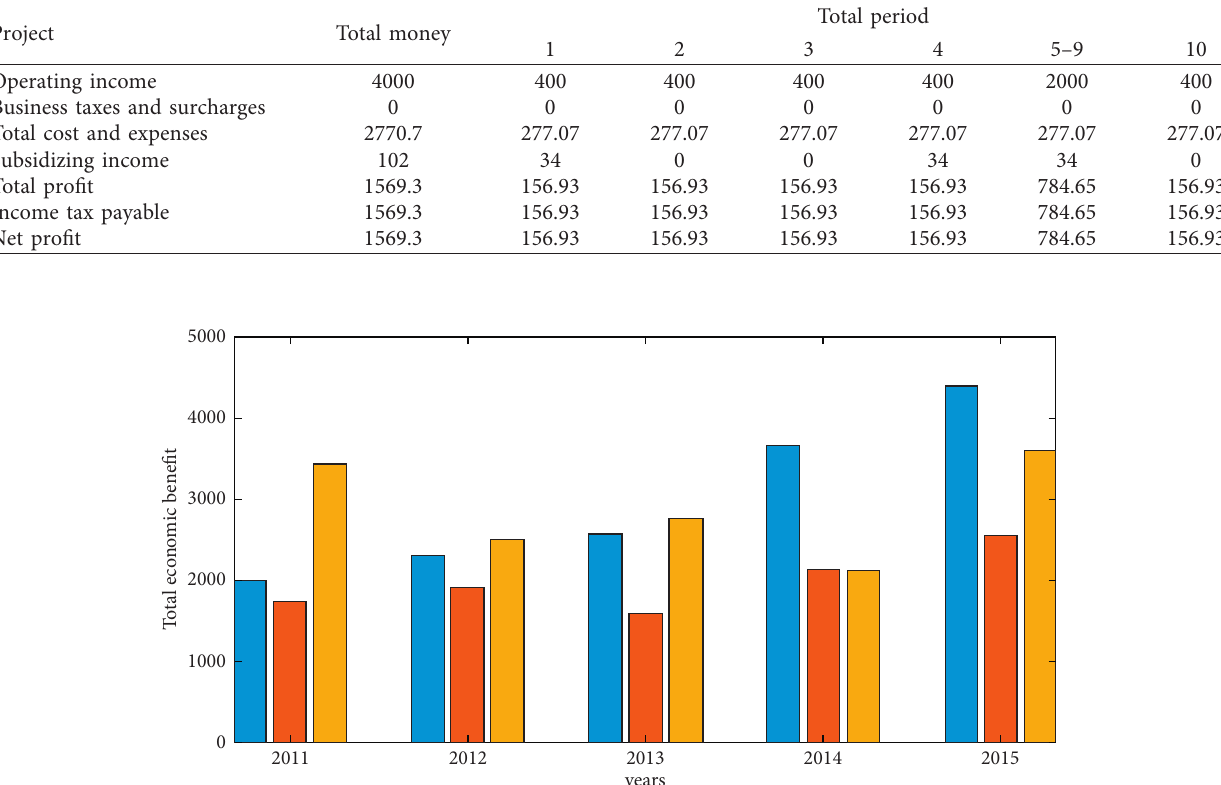
Table 1: Prediction of profit from investment in Agricultural Internet of Things projects.